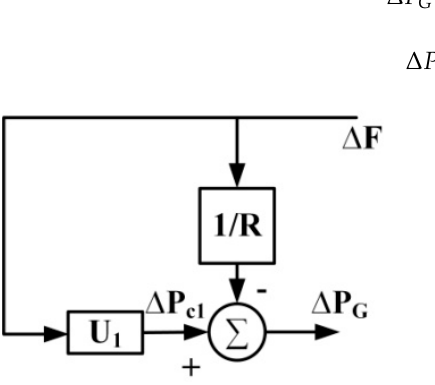
Figure 4. The control block of the